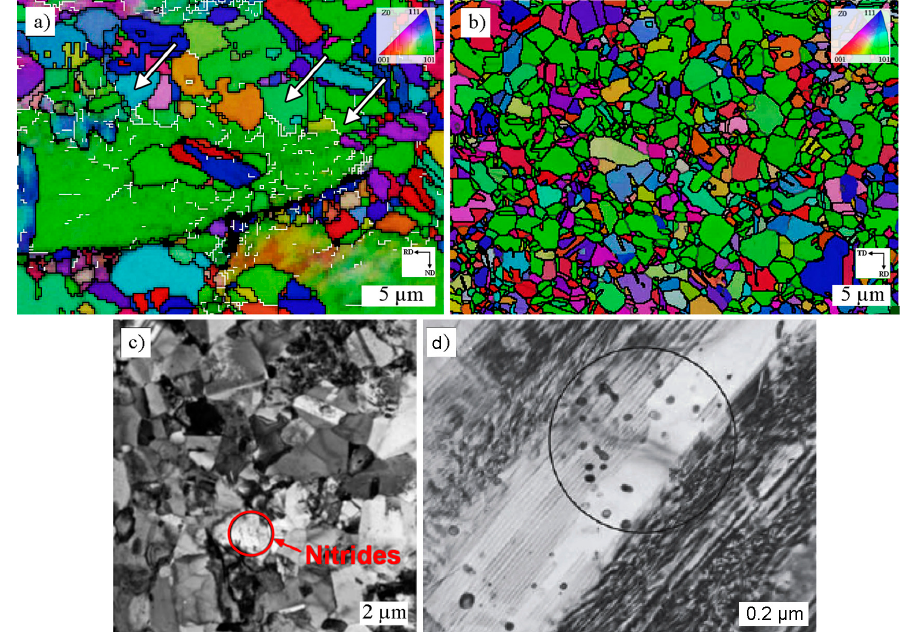
Figure 3. Reversion in 301LN ASS occurred by the shear reversion ( a ), where dislocation free grains are formed by continuous recrystallization (arrows pointing out such subgrains) [29], diffusional reversion ( b ) (reproduced from [84], with permission from Elsevier, 2017) and diffusional reversion with chromium nitride precipitation ( c , d ) (reproduced from [22], with permission from Springer Nature, 2007). Figure ( a ) preprinted with permission, 2020, MDPI; ( c , d ) preprinted with permission, 2020, Springer Nature.